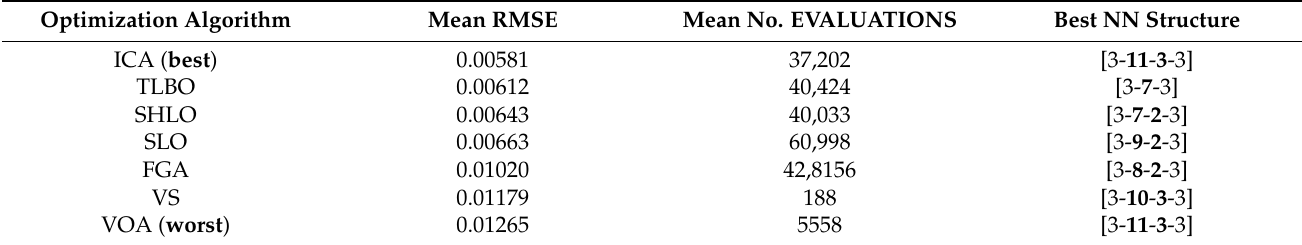
Table 1. The algorithms sorted according to their performance.